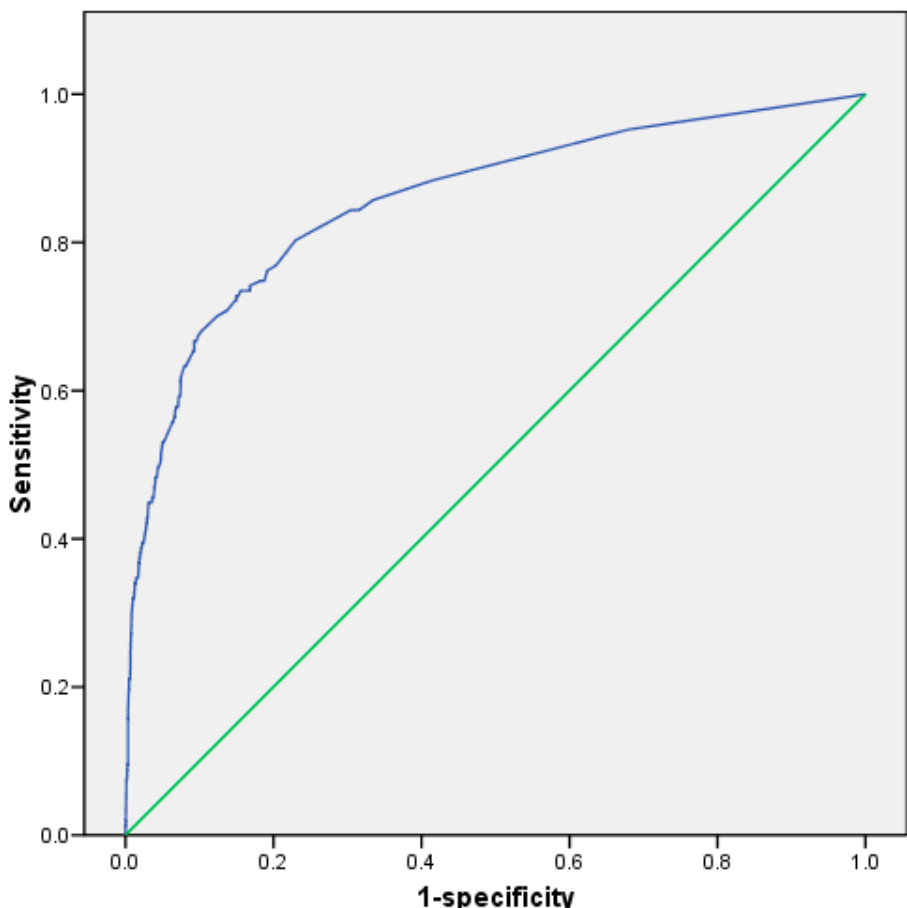
Figure 2. ROC curve for regression model including demographics, cardiovascular risk factors, clinical characteristics, and cerebral and vascular topography (AUC: 0.857). AUC: area under the curve; ROC: receiver operating characteristics.